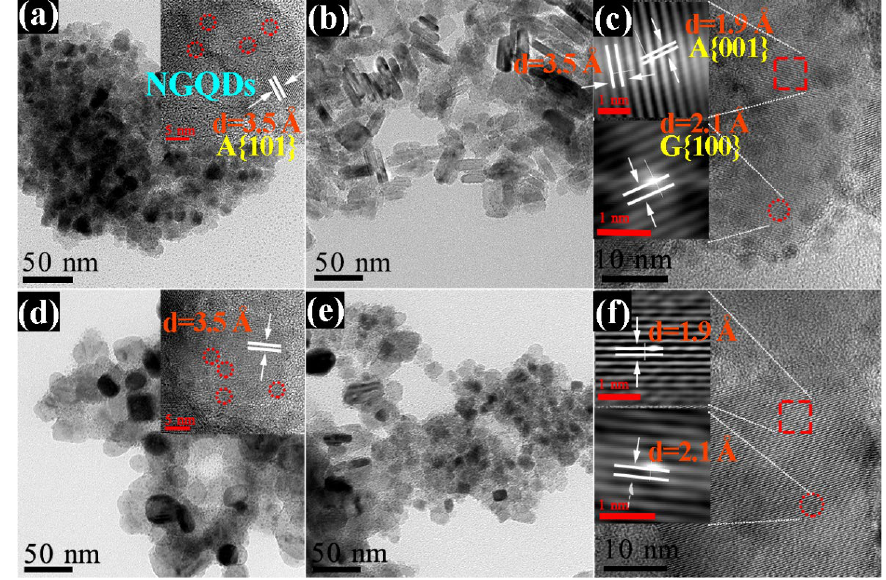
Figure 3. TEM images of ( a ) T0-NGQDs, ( b , c ) T1-NGQDs, ( d ) T2-NGQDs, and ( e – f ) T3-NGQDs. The inset in ( a ) is the HR-TEM image of T0-NGQDs. The inset in ( c ) is the autocorrelated HRTEM lattice images recorded from the corresponding selected areas. The inset in ( d ) is the HRTEM image of T2-NGQDs. The inset in ( f ) is the autocorrelated HRTEM lattice images recorded from the corresponding selected areas.